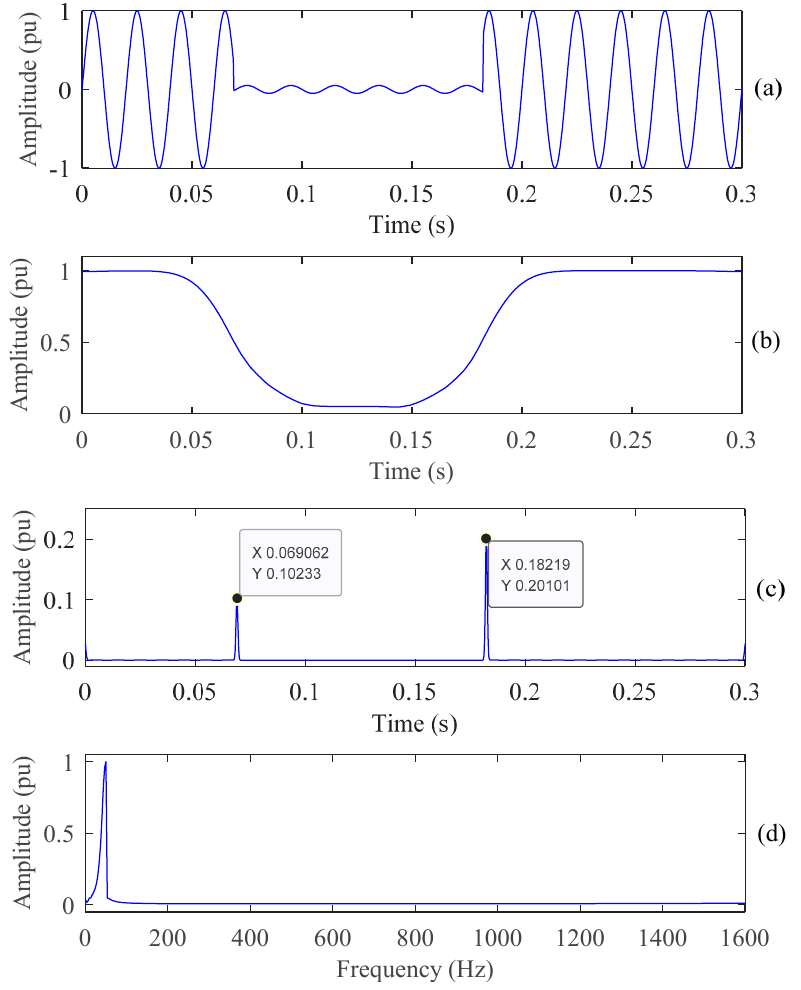
Figure 4. Voltage interruption and related STA : ( a ) Voltage interruption; ( b ) TvA ; ( c ) TvHFA ; ( d )